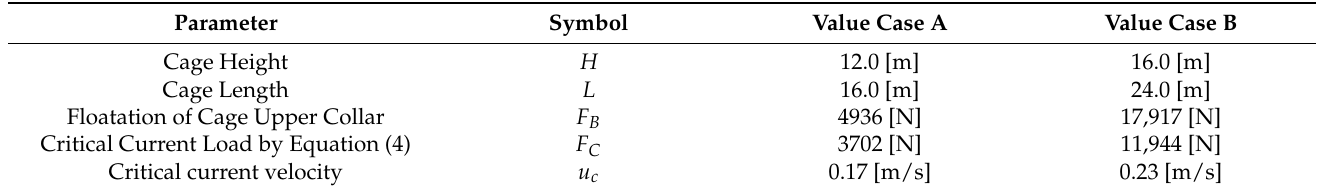
Table 15. Assessment of the critical opposing current for two systems with operational